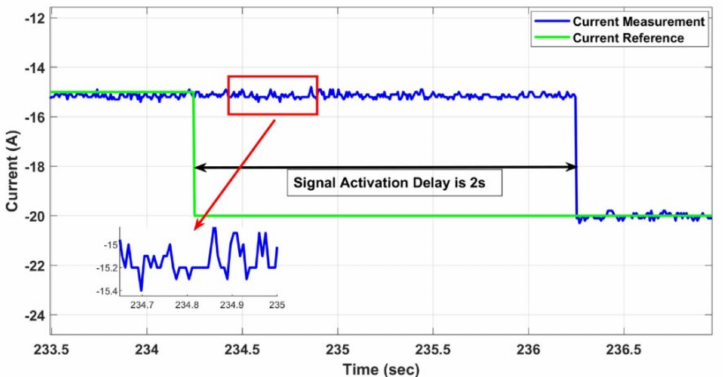
Figure 20. Actual hardware response delay compared to the reference signal.